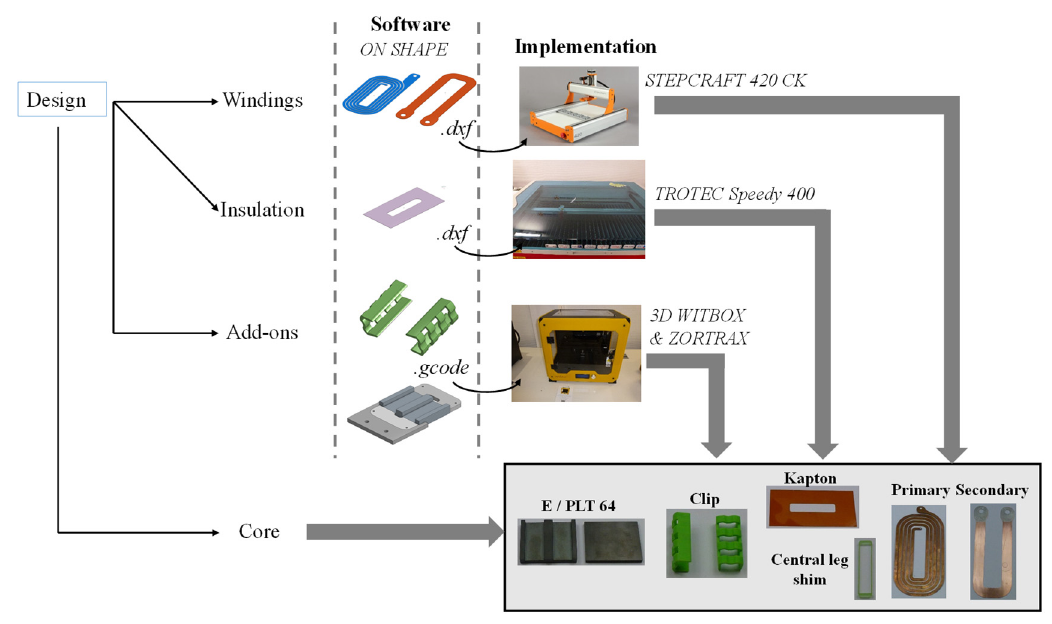
Figure 4. Process